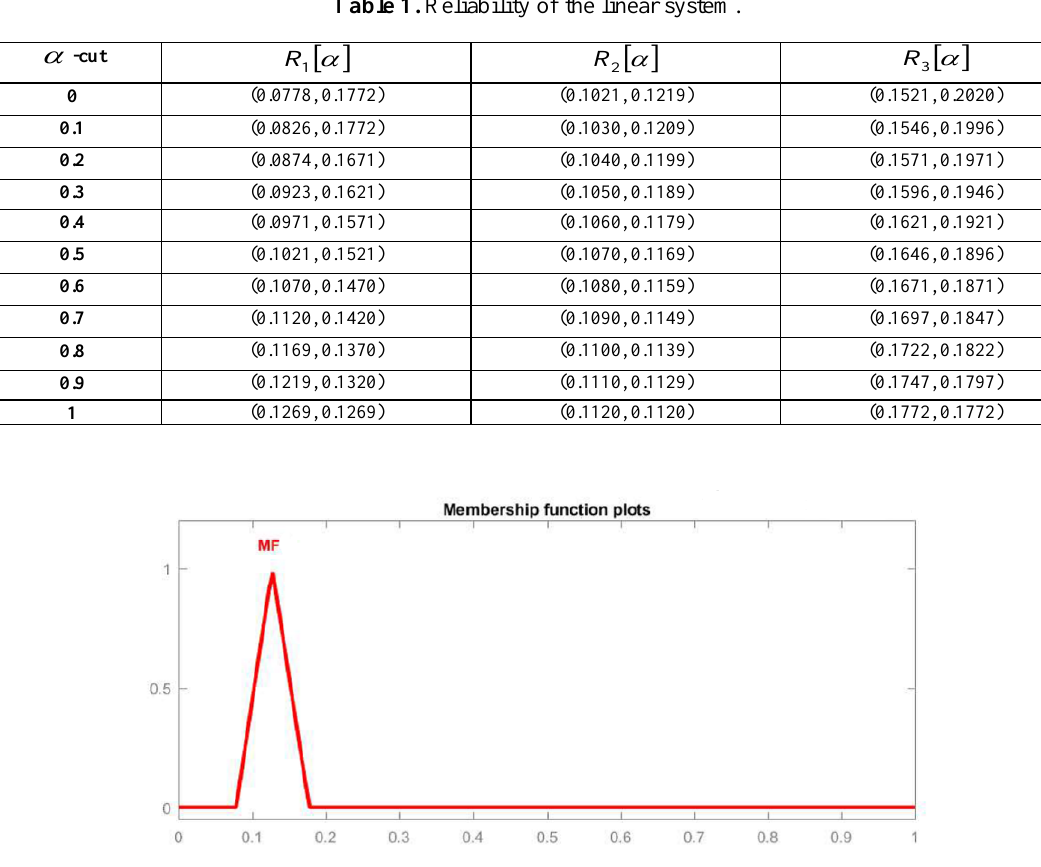
Figure 1. Membership function of R 1 ( α ) for linear system.